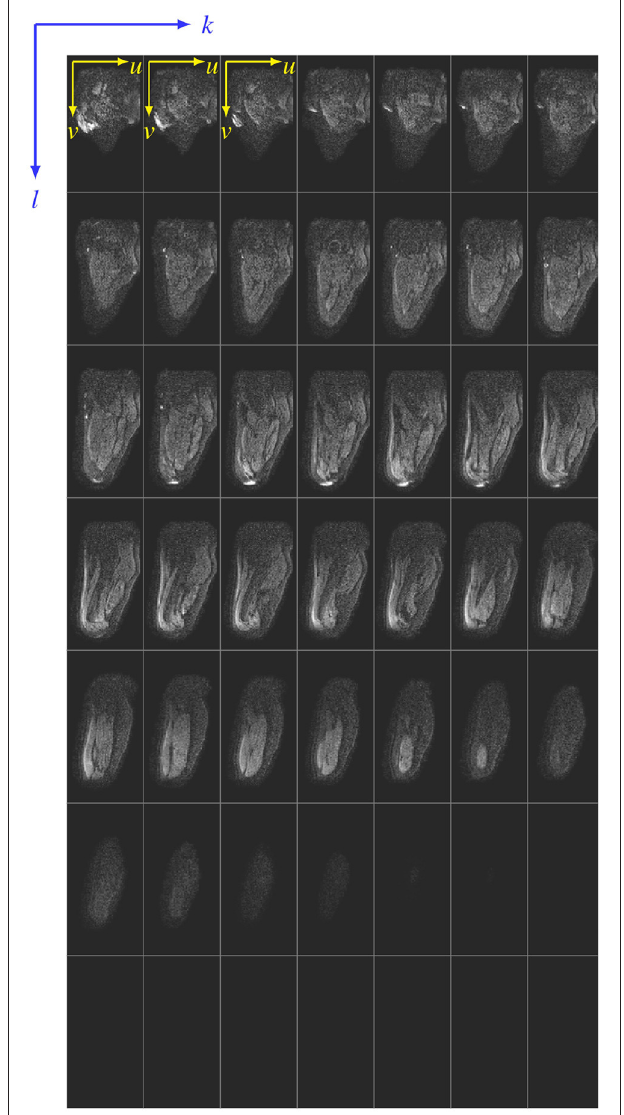
FIGURE 1 | Siemens mosaic file. A sample mosaic image is shown here. For the sake of illustration, the 2D slices that make up the mosaic are separated by thin lines. Any pixel in the mosaic can be accessed using two coordinate systems–the [ k , l ] coordinate that references a 2D slice in the mosaic, and the [ u , v ] coordinate that references a pixel in the 2D slice referenced by [ k , l